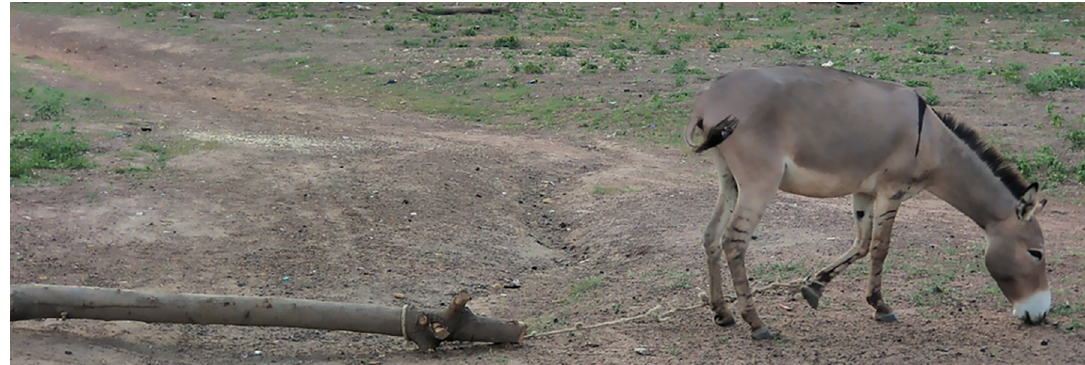
Fig 9. A donkey on a short-term tether in Fielmon. Source: © Maggs, 2019, cc BY 4.0.